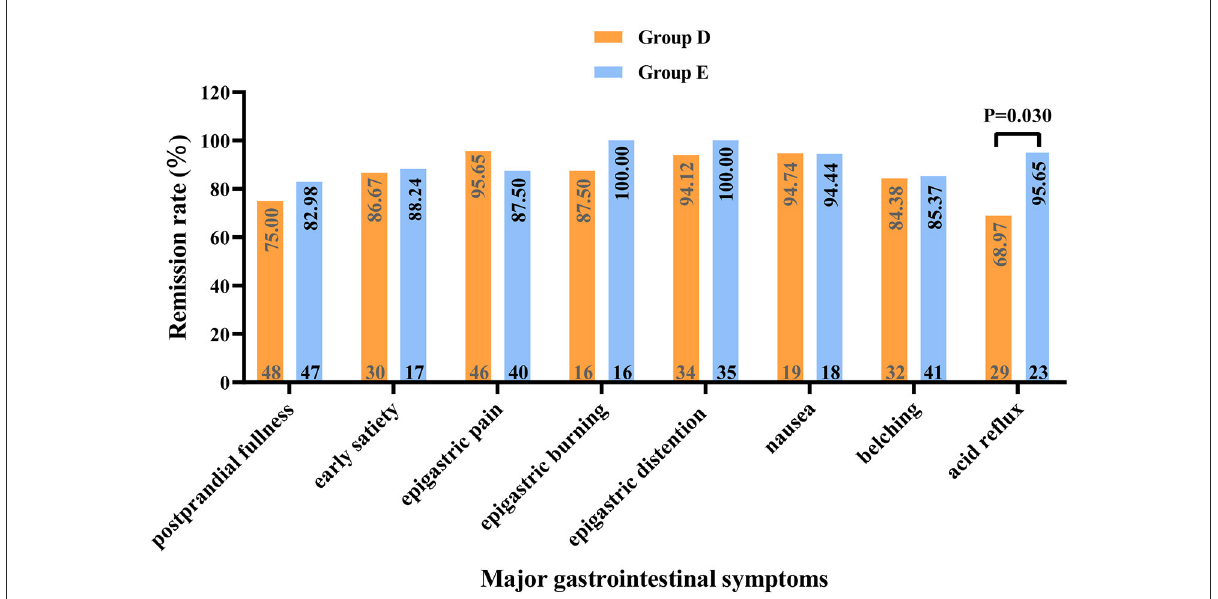
FIGURE5 Relief of major gastrointestinal symptoms in patients with functional dyspepsia without mood disorders at 8 weeks of treatment. The numbers at the top and bottom of each column correspond to the remission rate and the number of patients with the respective symptom (before treatment). Group D: nizatidine; Group E: